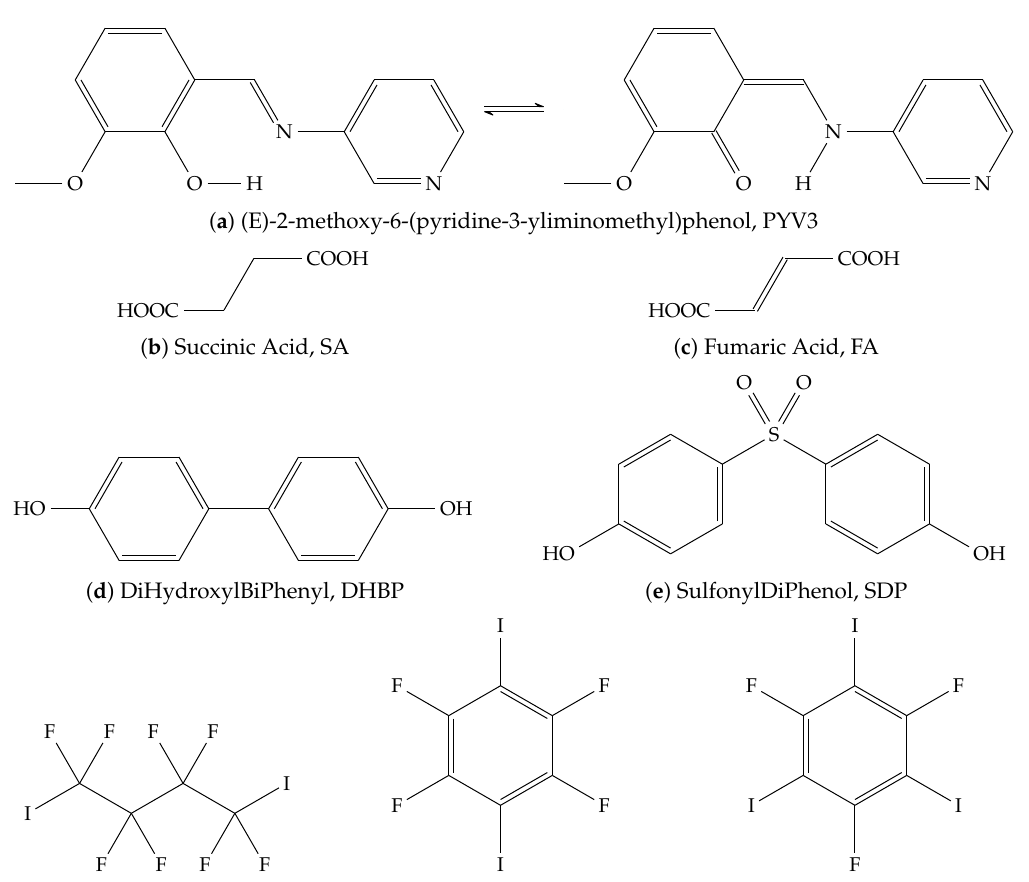
Scheme 1. Structures of PYV3 and its coformers, ( a ) anil and its enol–keto equilibrium; coformers interacting by H-bond ( b – e ) or X-bond ( f – h